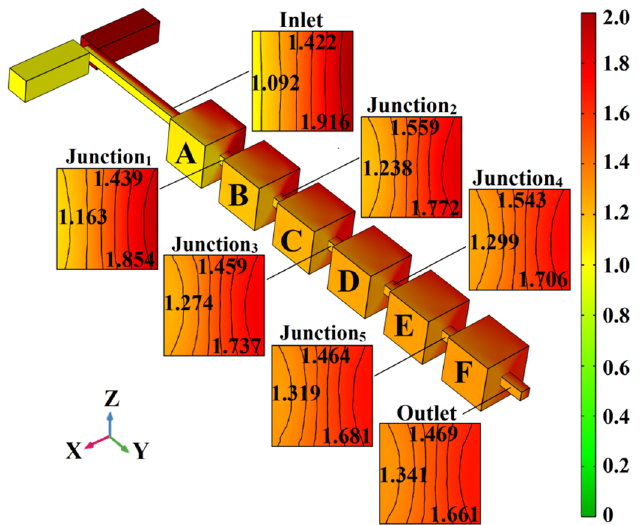
Figure 3. C oncentration distributions of the surface and junction cross-section of the micromixer with the initial repetitive structure. the initial repetitive